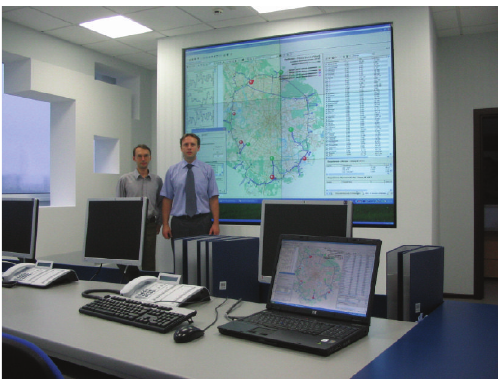
Figure 3: Example of the Alfargus/Mosregiongaz computer system application in the control room of GAZPROM Mezhregiongaz Moscow